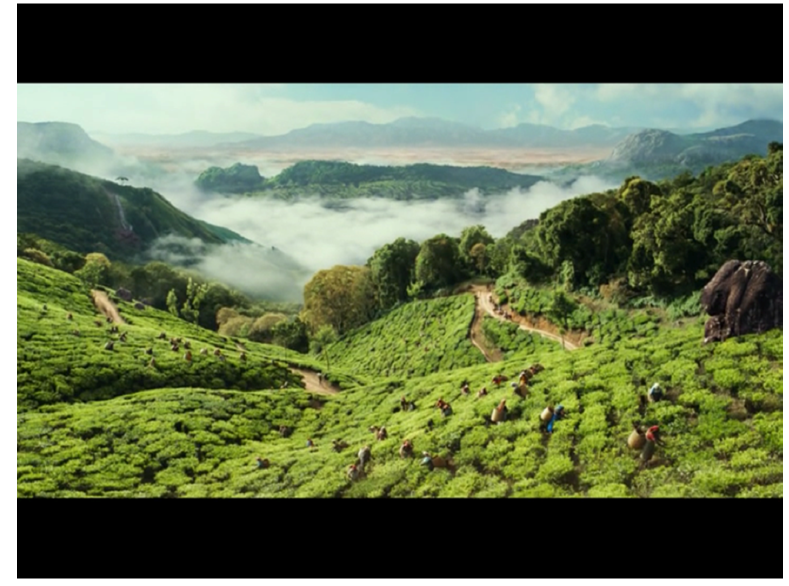
Figure 1. Teapickers in Munmar, in the style of Chinese landscape painting.